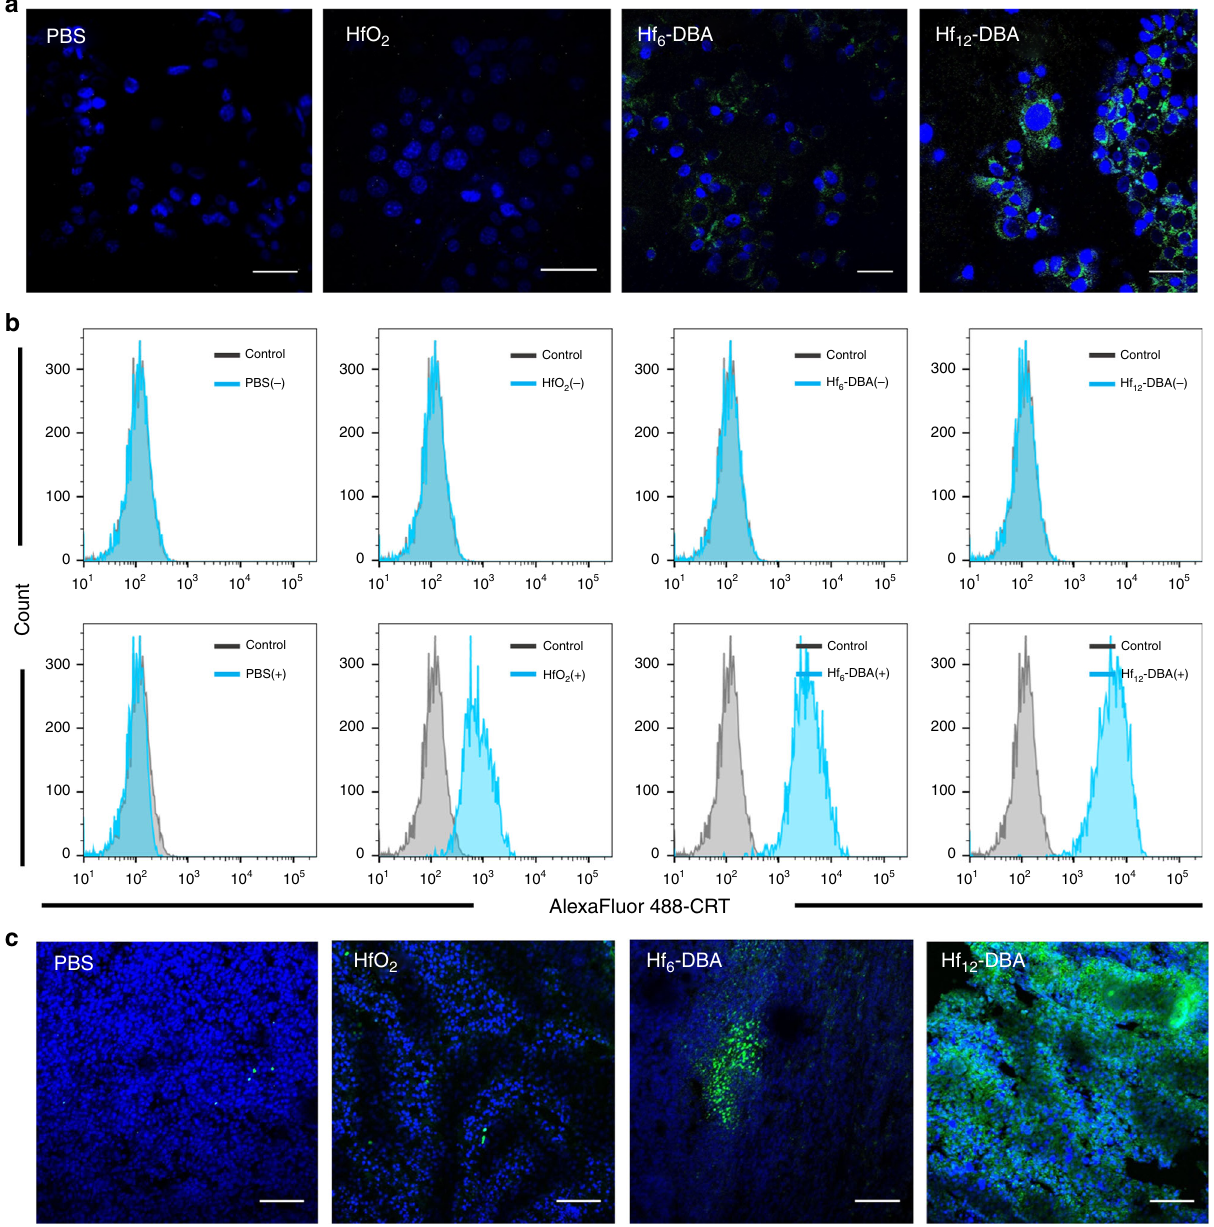
Fig. 5 In vitro and in vivo immunogenic cell death studies. In vitro CRT exposure on the cell surface of CT26 was assessed after incubation with PBS, HfO 2 , Hf 6 -DBA, or Hf 12 -DBA with X-ray irradiation by immuno fl uorescence microscopy ( a ) and fl ow cytometry ( b ). ( + ) and ( − ) refer to with and without irradiation, respectively. c In vivo CRT exposure was evaluated on sectioned tumor slides of CT26 tumor-bearing mice after 5 consecutive days of X-ray irradiation. Both in vitro confocal images and fl ow cytometry analyses were obtained with two repetitions. One of two repetitions with similar results is shown. The in vivo confocal images were obtained without repetition. Scale bar = 20 µ m ( a ) or 100 µ m ( c